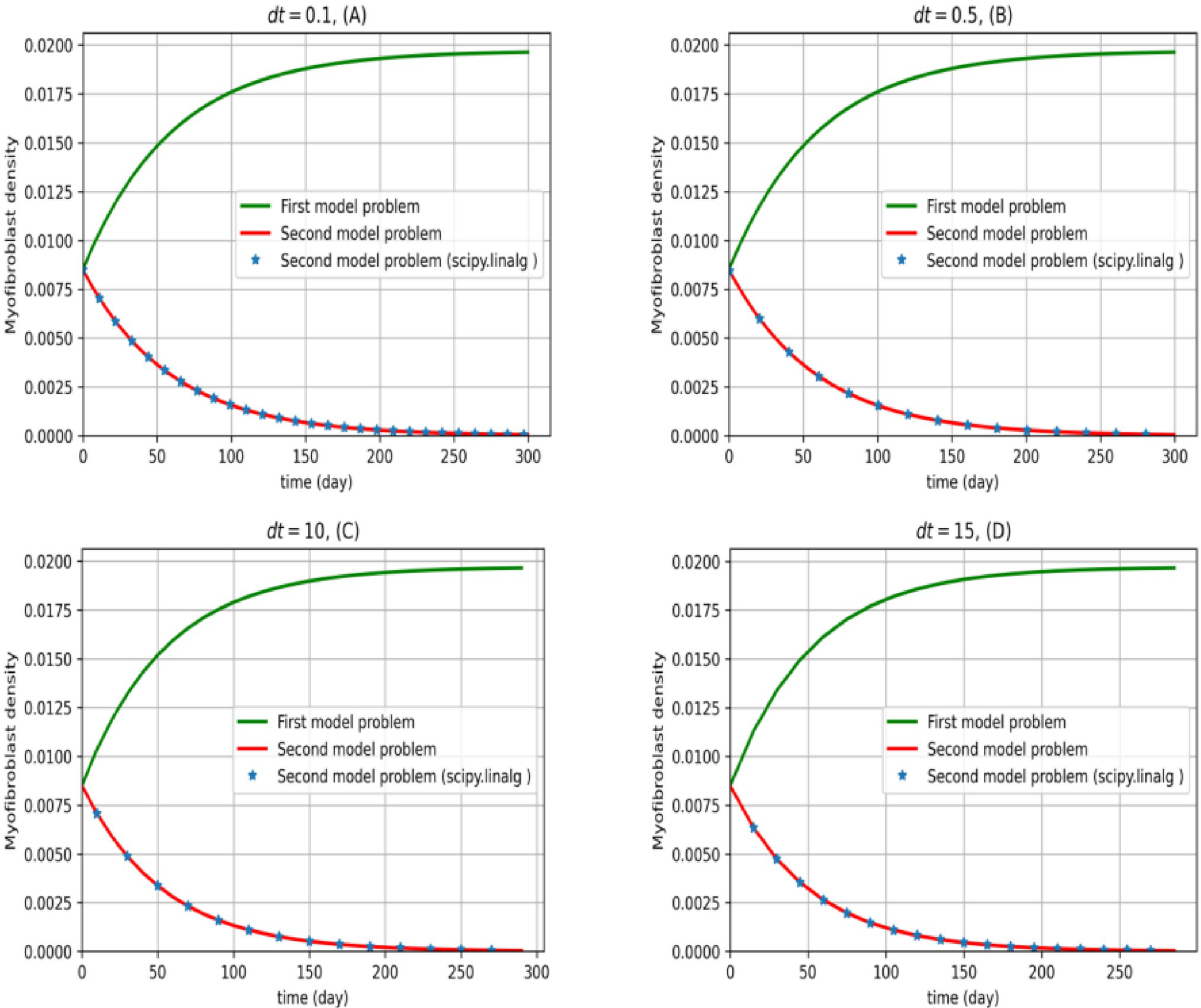
Fig 4. First and second model problems and comparison with a package. Myofibroblast density against time is plotted. The first model problem (dynamical system (8) and (9)) is solved by the central finite differences explicit method (green). The second model problem (7)–(9) by scipy.linalg package ( ? ) and current technique (red) are solved. Plots are depicted for dt = 0.1, 0.5, 10, 15 in Euler approximation. As it is shown, the myofibroblast vanishes to zero for all the dt values. However, from a mathematical point of view, the results for dt = 0.1 are more reasonable. This means that after almost 240 days of controlling TGF- β , the myofibroblast vanishes. All calculations are done for 36 nodes in the x-y